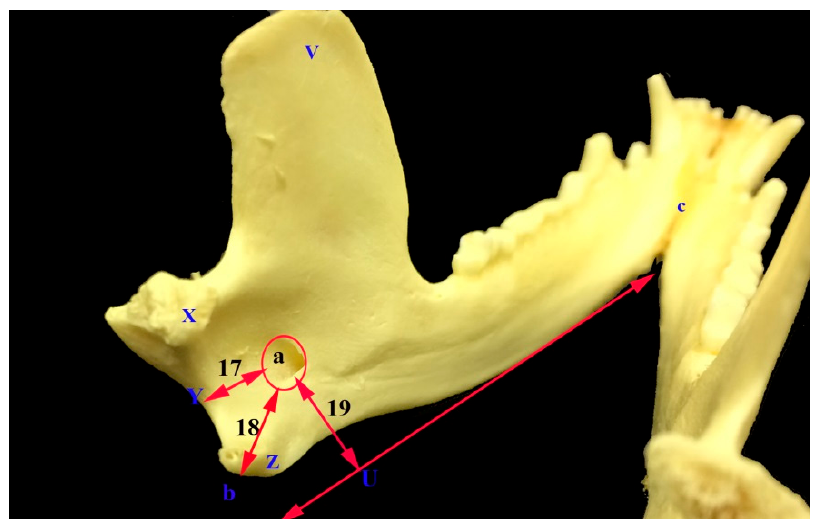
Figure 5. Photograph of lateral view of the mandible of the common opossum showing the mandible measures. M (1–4) lower molar teeth; N incisor teeth; O canine; P (1–3) lower premolar teeth; Q lateral alveolar border; R lateral alveolar border of first lower premolar tooth; S rostral mental foramen; T caudal mental foramen; U base of mandible; V coronoid process; W highest point of the coronoid process; X condylar process; Y caudal border of the mandible; 11 mandibular length; 12 distance between lateral alveolar border and rostral mental foramen; 13 distance between the caudal border of the mandible to the caudal mental foramen; 14 distance between the rostral and caudal mental foramina; 15 maximum mandibular height; and, 16 distance between the condyloid fossa to the base of the mandible.